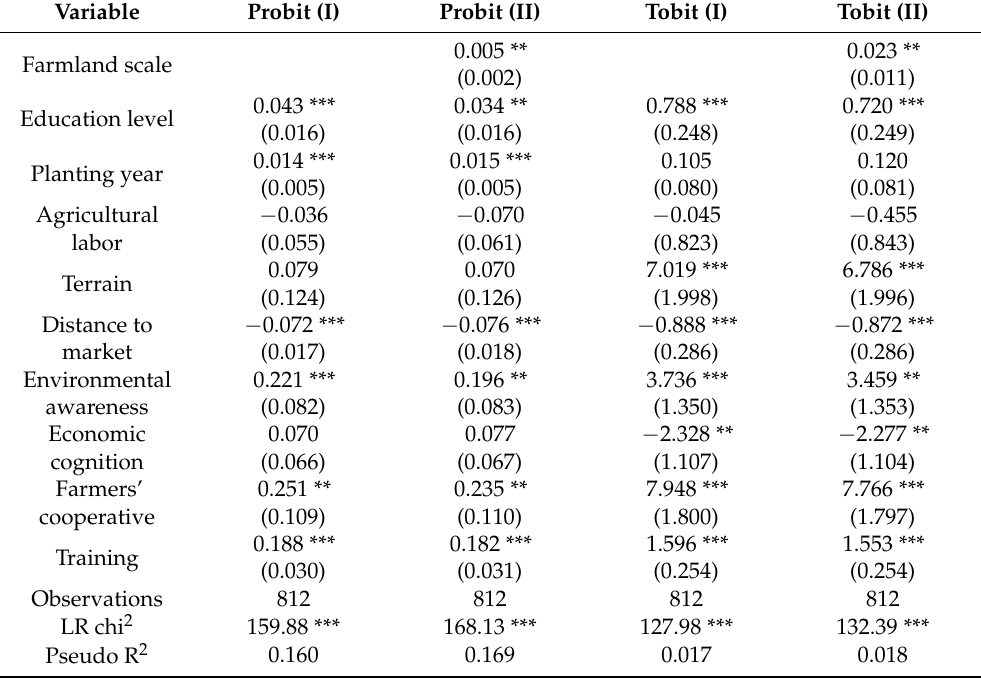
Table 3. Estimation results of the impact of farmland scale on citrus farmers’ organic fertilizer